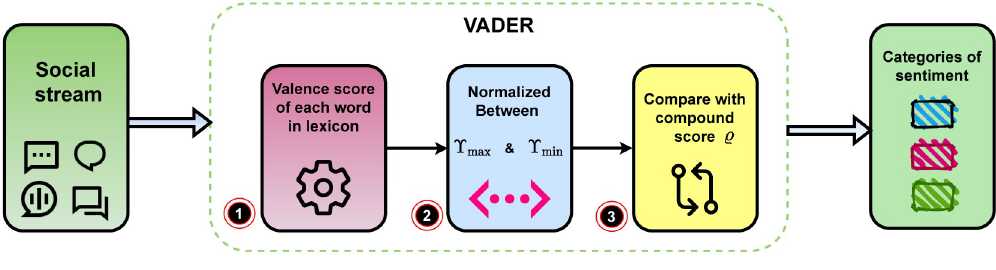
Fig 9. Architecture of